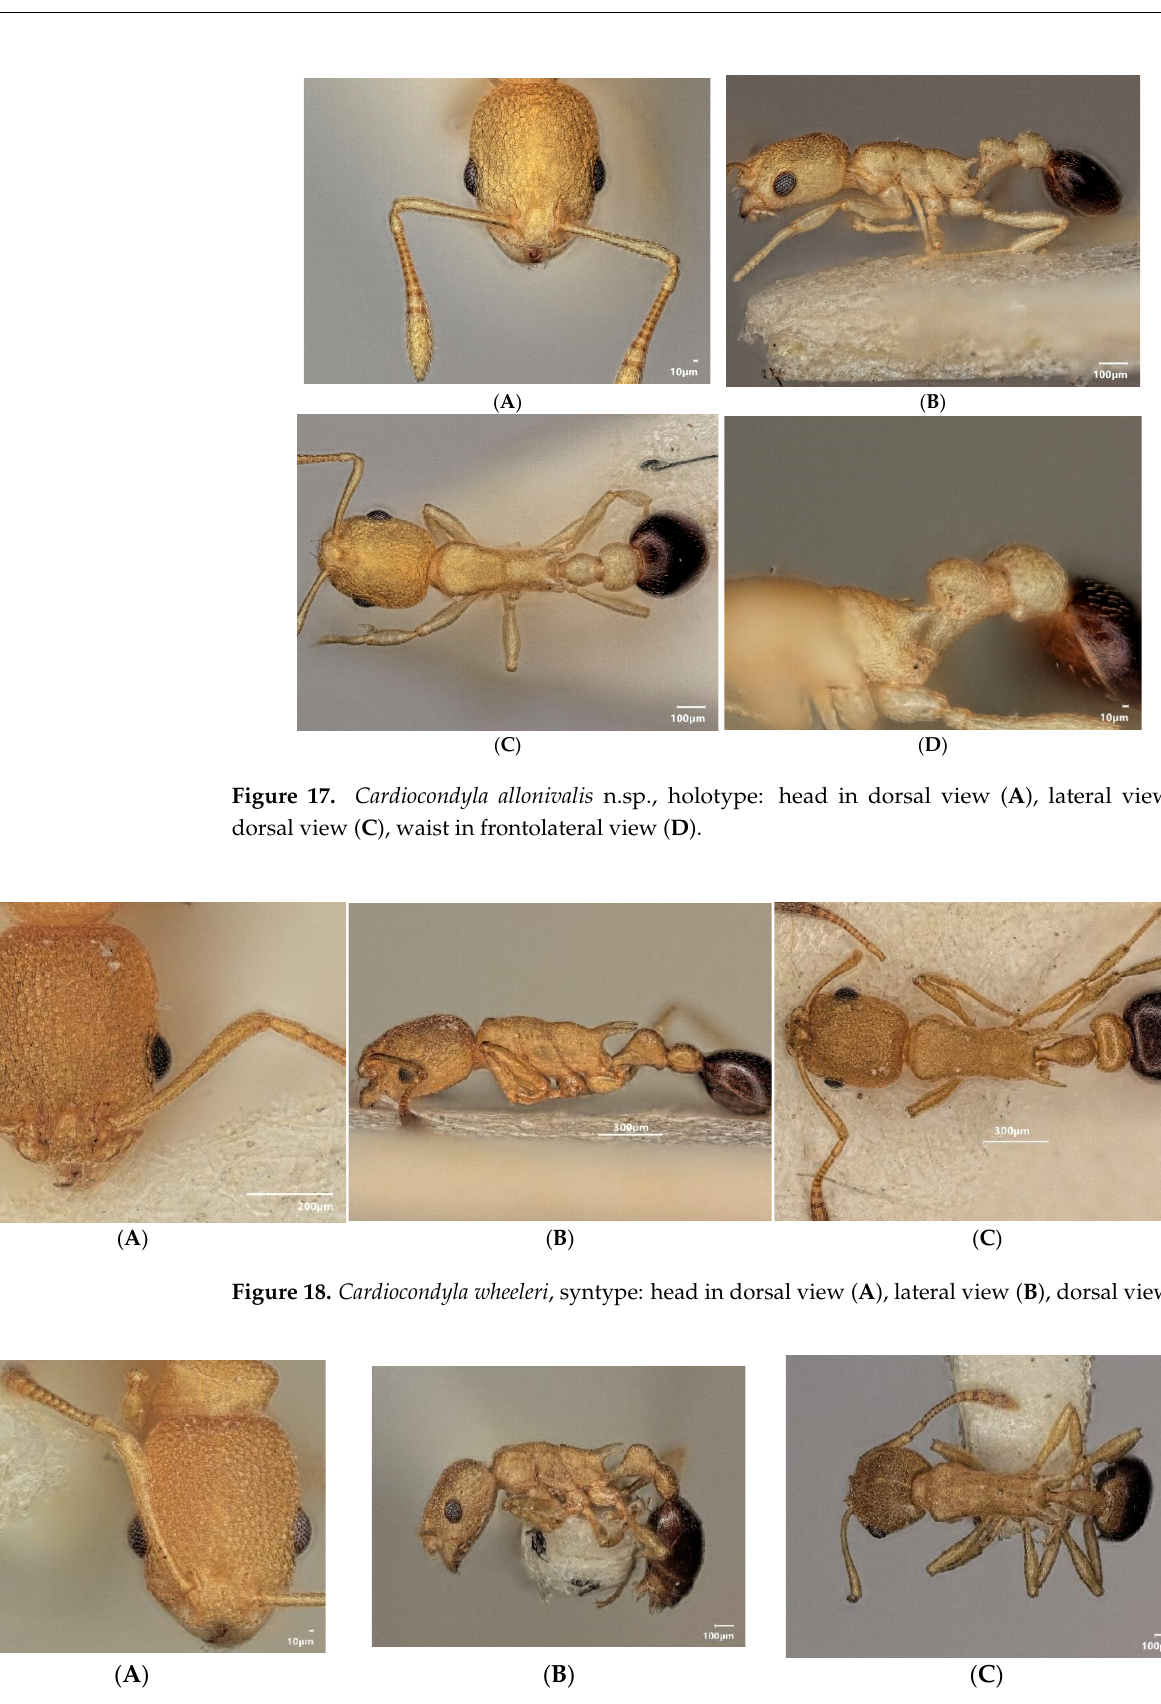
Figure 19. Cardiocondyla excavata n.sp., holotype: head in dorsal view ( A ), lateral view ( B ), dorsal view ( C ).